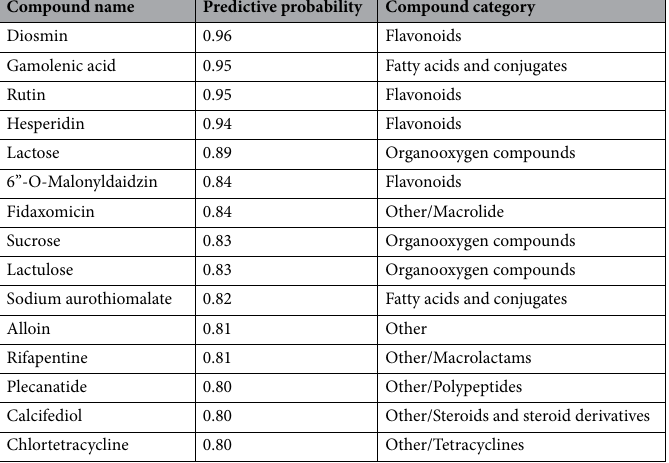
Table 3. Chemical compounds from the screening database with a predictive probability of 0.80 or above for increasing the of C.